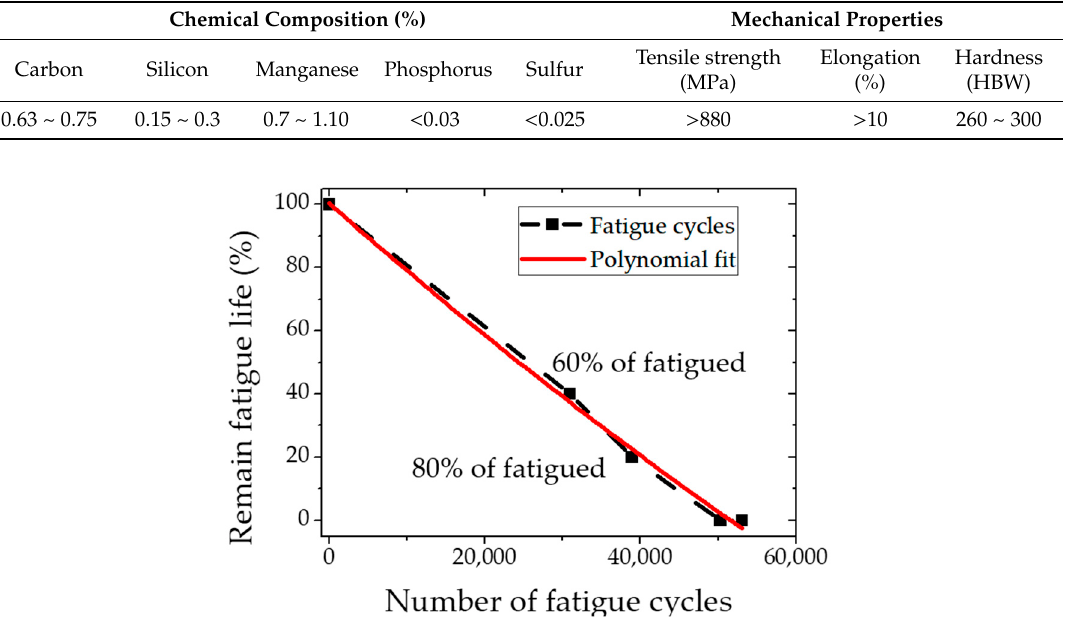
Table 1. Chemical composition and material properties of KR 60.